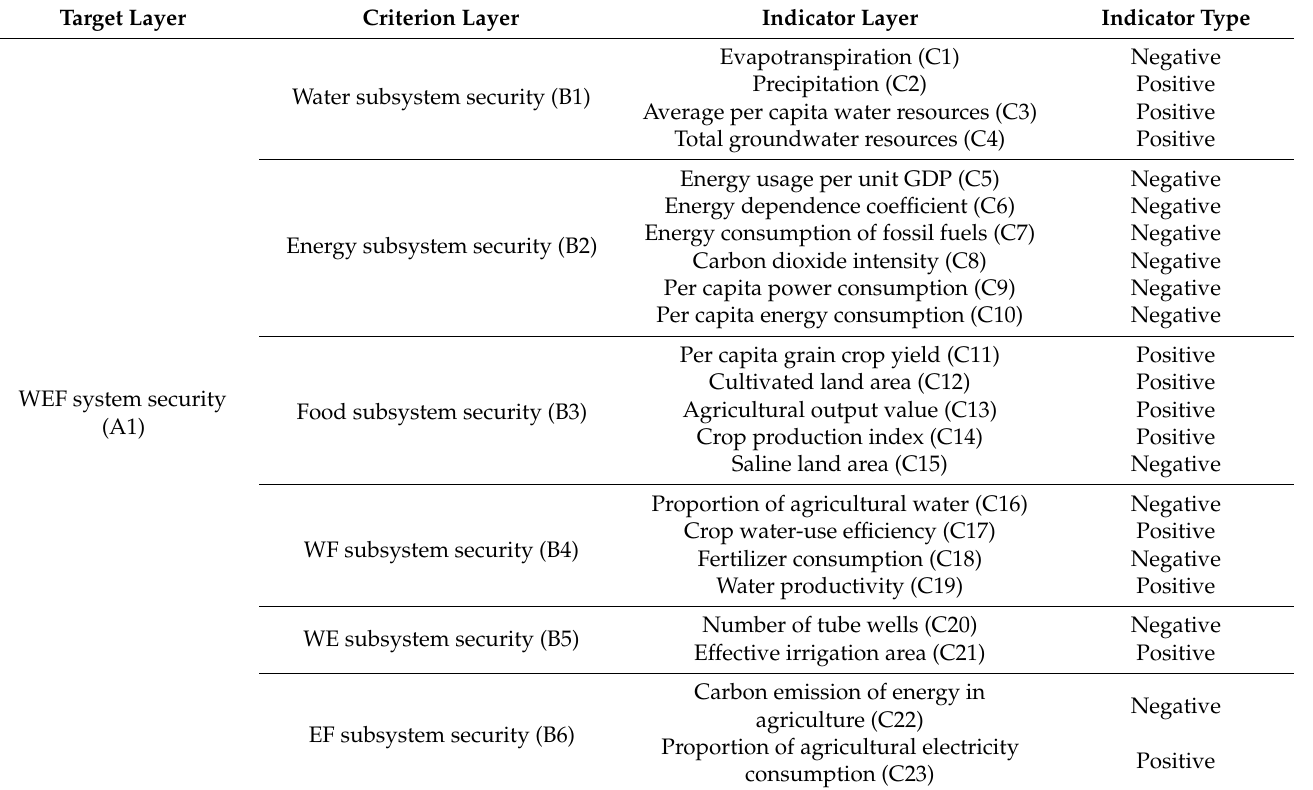
Table 2. Evaluation indicator